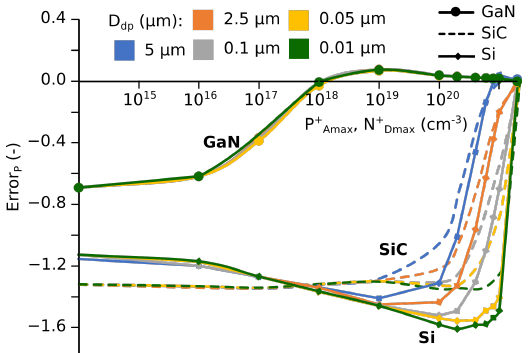
= N + for different thickness of the Dmax Amax